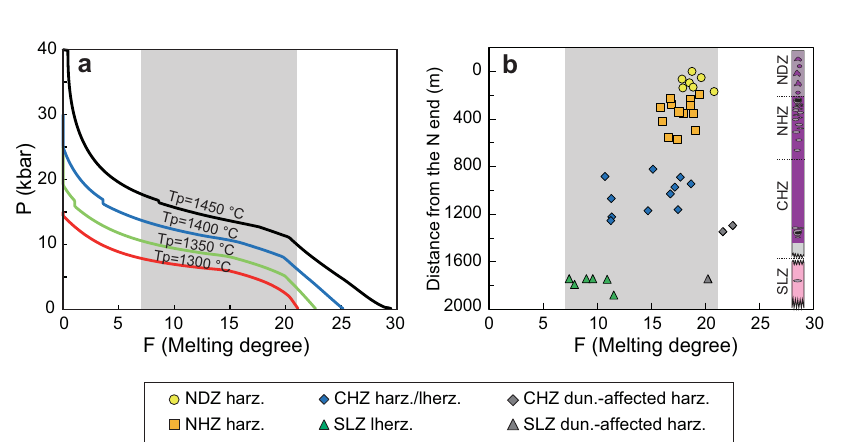
Fig. 4 | Mantle thickness comparison between results from decompressional melting modeling and observations from the Kangjinla ophiolitic section. Variationsofpartialmeltingdegrees(F)versuspressure(P,kbar)fortheisentropic decompressional melting residues ( a ), and F versus distance from the north end (m) for the Kangjinla peridotites ( b ). F in a was acquired by thermodynamic